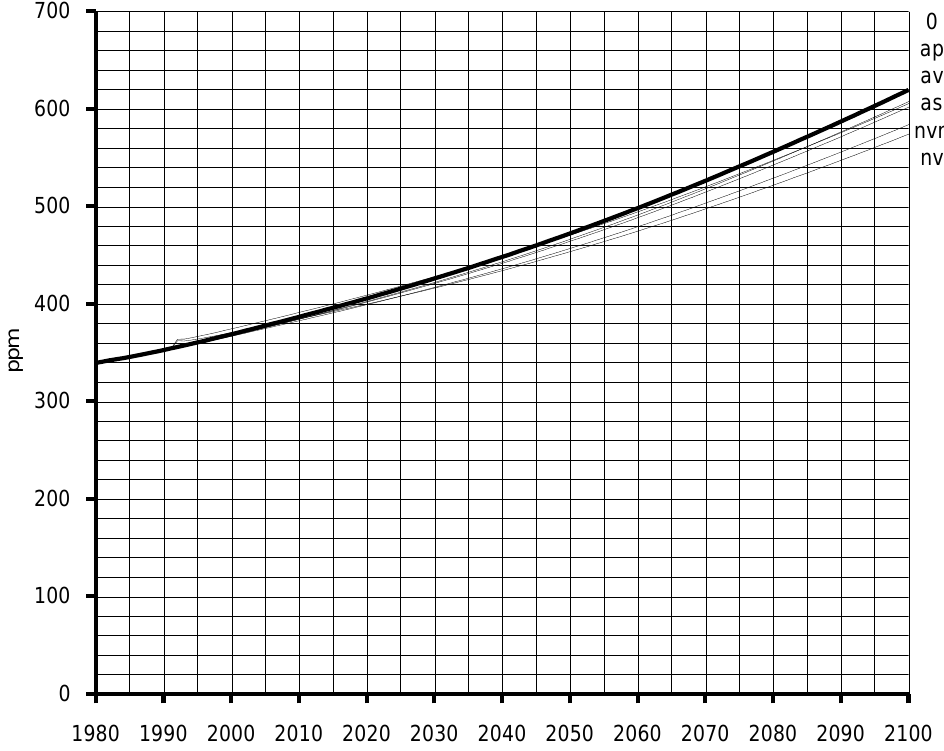
Figure 9. Same scenario assumptions as in Figure 8, but ( with combustion of standing biomass for energy on possibly deforested areas) in a “+1%/a” CO 2 emission growth scenario. Moreover, here, the net mitigation effect of biomass energy strategies lies in the order of magnitude of only 50 ppm CO 2 until 2100—while the difference to all “+3%/a” scenarios amounts to as much as 600 ppm.